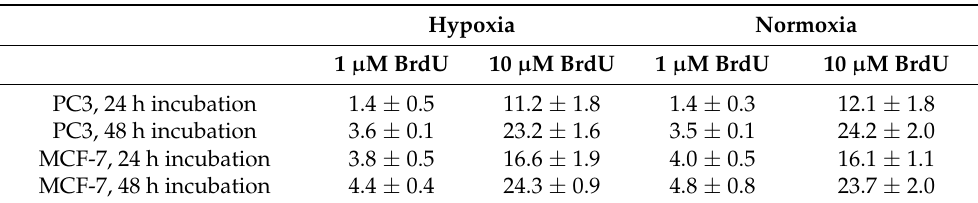
Table 1. Incorporation of BrdU [%] a applied at concentrations of 1 µ M or 10 µ M into genomic DNA. The experiment was performed in three